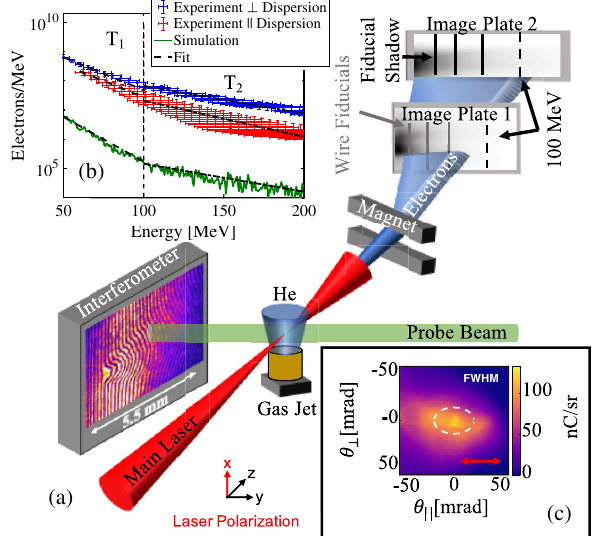
FIG. 1. (a) Experimental setup. The electron beam is dispersed by a 0.6 T magnet onto two BAS-MS image plates after passing through three wire fiducials. A frequency-doubled probe beam is co-timed with the main pulse and provides on-shot interferometry of the plasma channel with a magnification of 3. (b) The electron energy spectrum for two different shots using identical laser and plasma parameters dispersed perpendicular and parallel to the laser polarization in blue and red, respectively, along with the simulated electron spectrum in green. All three spectra are fit to single-temperature distributions below ( T 1 ) and above ( T 2 ) 100 MeV; the two regions are separated by a dashed black line. The experimental spectra exhibit shot-to-shot variations of the single-shot laser system. (c) An undispersed electron beam